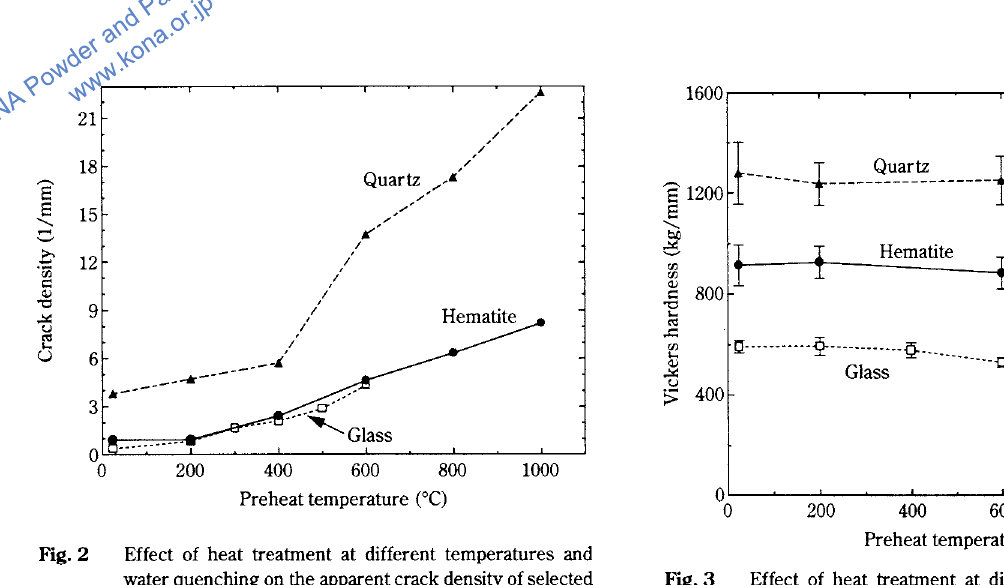
Fig. 3 Effect of heat treatment at different temperatures and water quenching on Vickers hardness of selected